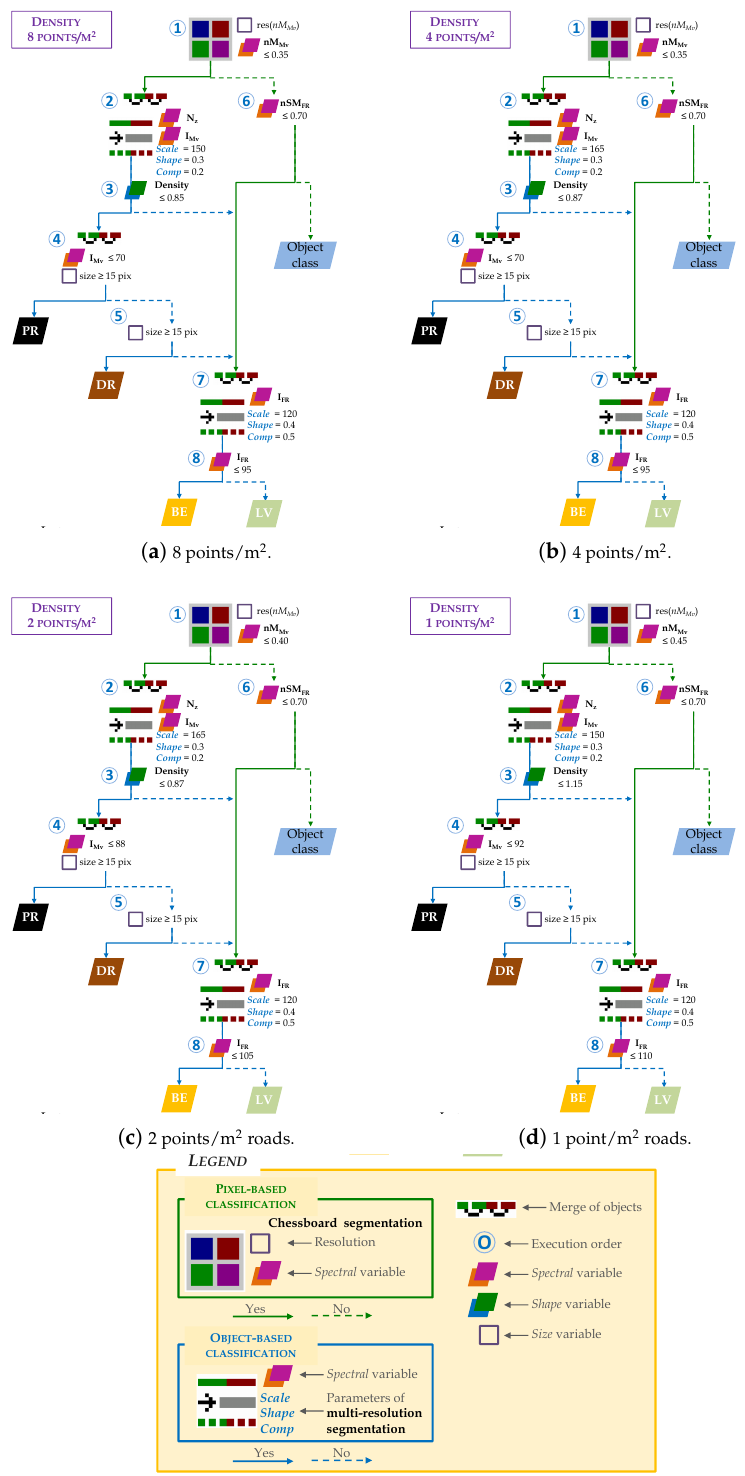
Figure A1. Decision